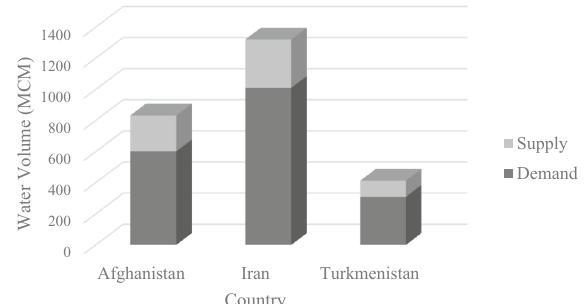
Figure 4. Average annual volume of water supply and demand calculated with the non-cooperative allocation approach (MCM = 10 6 m 3 ).